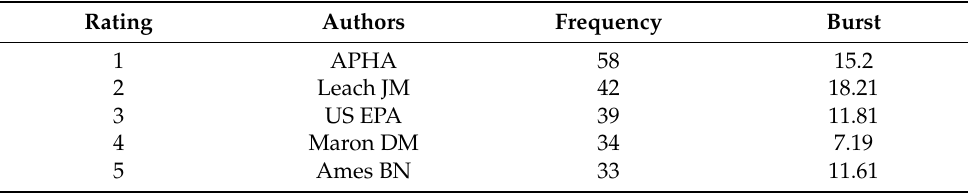
Table 5. The list of the top 10 cited authors and organizations contributing to the field of industrial effluent and sludge toxicity analysis from 1951 to 2020 was performed via CiteSpace software. The authors and organizations’ respective scientometric characteristics have also been presented, with their frequency and burst parameters.